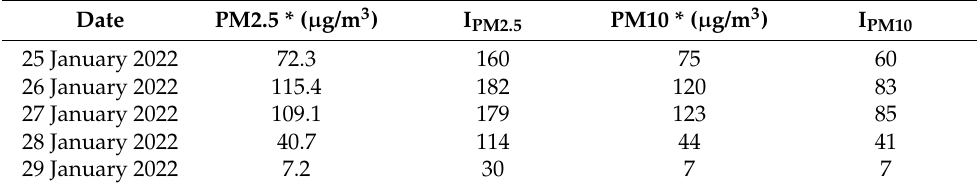
Table 5. Air Quality Index for Košice, DTIEE measurement.